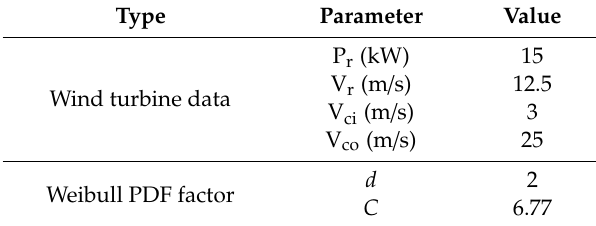
Figure 5. Day-ahead market price of a low-voltage MG. Table 3. Wind turbine data and Weibull probability density function (PDF)